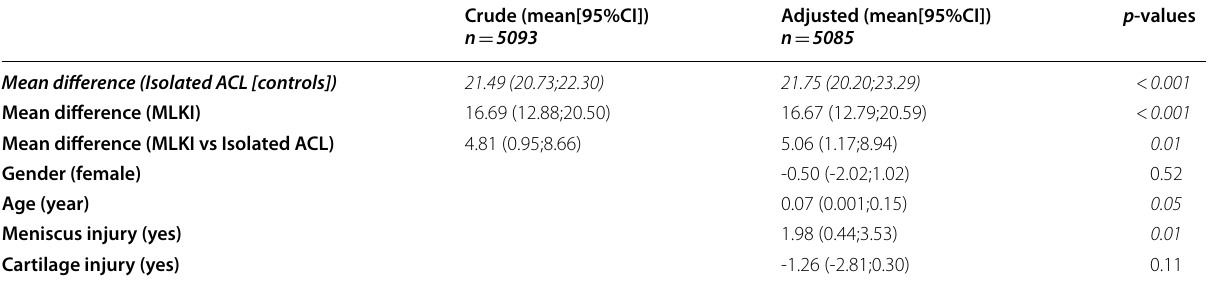
Regression model adjusted for gender, age, meniscus and cartilage injury. Data presented as mean (95%CI). p -values < 0.05 indicates if the variable influence on the adjusted mean